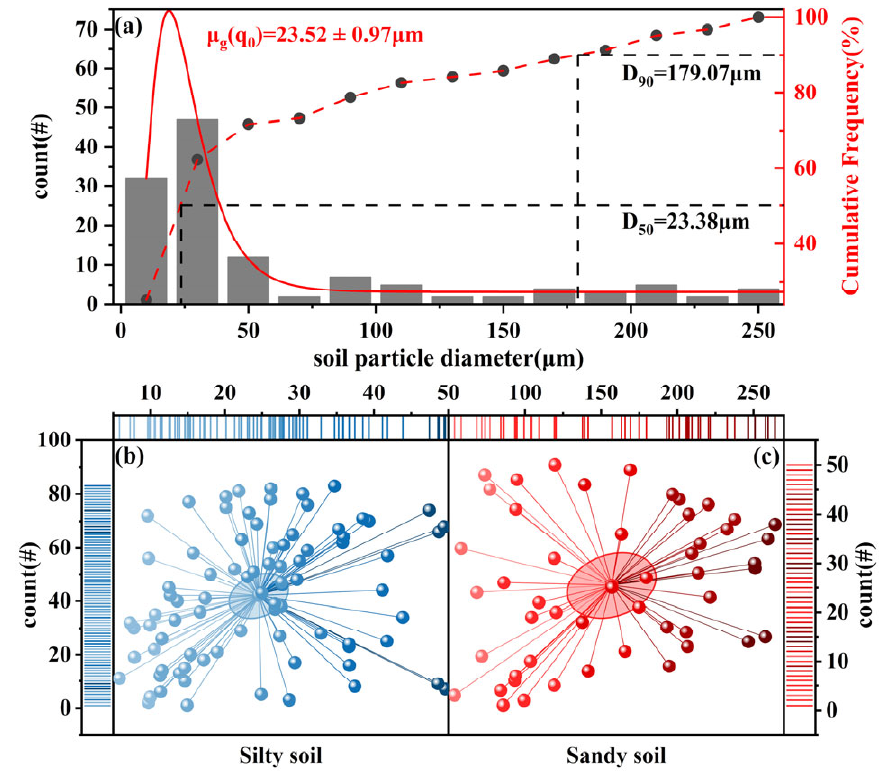
(cid:4666)𝑞 (cid:4667) rep ‐ 𝘨 (cid:2868)